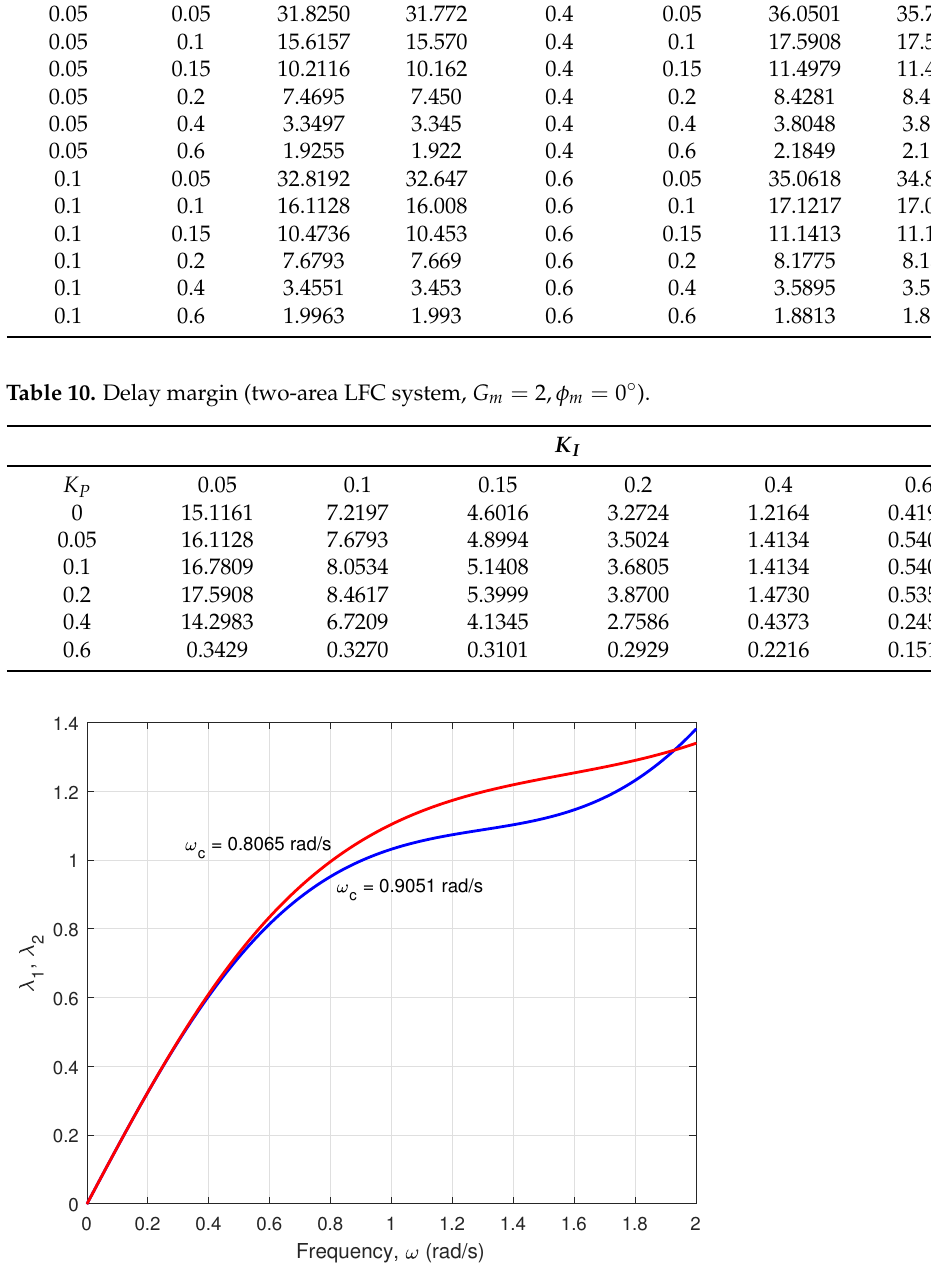
Figure 13. The generalized eigenvalues as functions of the